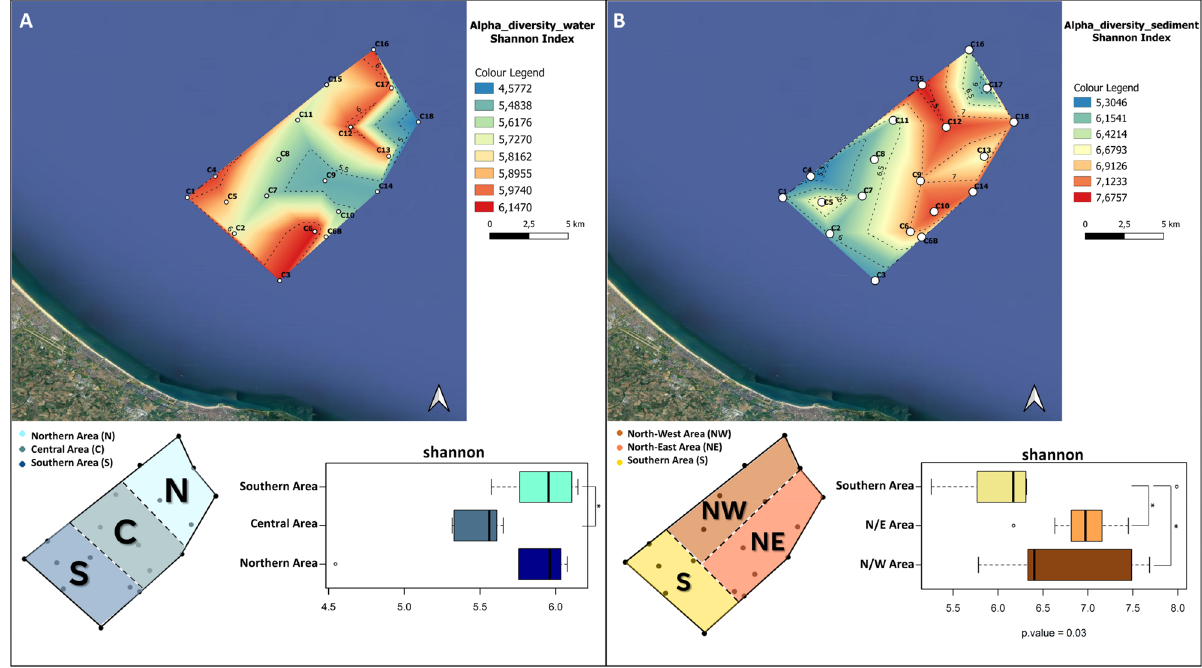
Figure 3. Representation of the alpha-diversity patterns in the area for both water and sediment samples. ( A ) (Upper part) Distribution of the alpha diversity values among water samples, generated with TIN interpolation of the single values. Colour scale from red to blue represents a decrease in alpha diversity; black lines represent contour lines of the interpolation. (Bottom part) Subset of samples divided into 3 areas based on Shannon diversity; for water samples, the Northern Area, the Central Area and the Southern Area were identified. Box plot of Shannon index calculated for the 3 identified areas of water samples. ( B ) (Upper part) Distribution of the alpha diversity values among sediment samples, generated with TIN interpolation of the single values. Colour scale from red to blue represents a decrease in alpha diversity; black lines represent contour lines of the interpolation. (Bottom part) Subset of samples divided into 3 areas based on Shannon diversity; for sediment samples, the North-West Area, the North-East Area and the Southern Area were identified. Box plot of Shannon